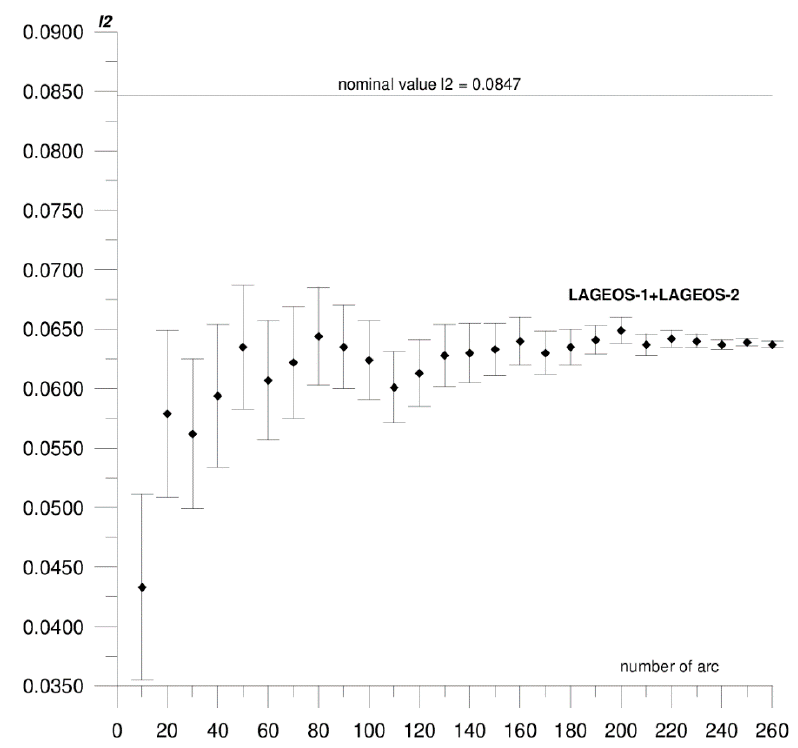
Figure 6. Sequential solution for the Mount Stromlo local h 2 parameter based on STELLA+STARLETTE data.